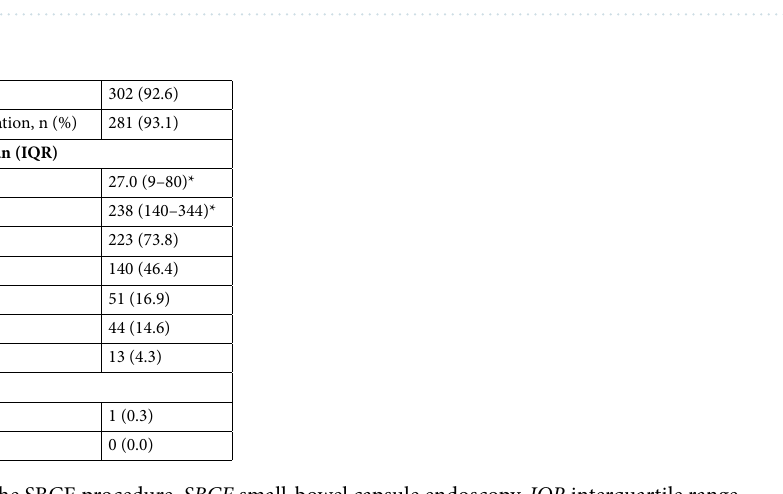
Table 5. Univariate and multivariate logistic regression analyses of factors associated with intestinal patency. CD Crohn’s disease, CI confidence interval, IDs inflammatory diseases, OGIB obscure gastrointestinal bleeding, OR odds ratio.